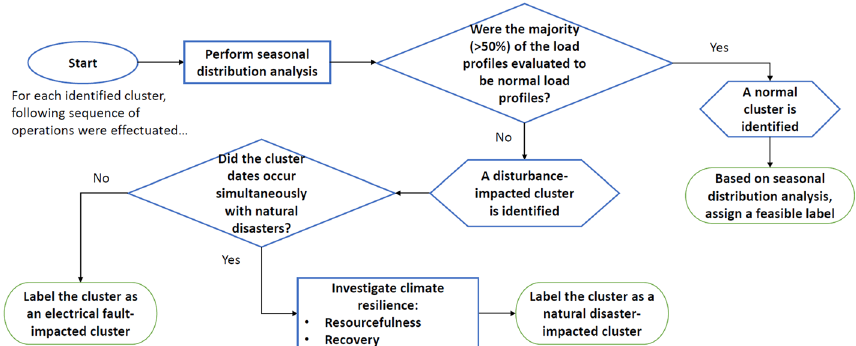
Fig. 3 Flowchart of feasible label assignment for identified